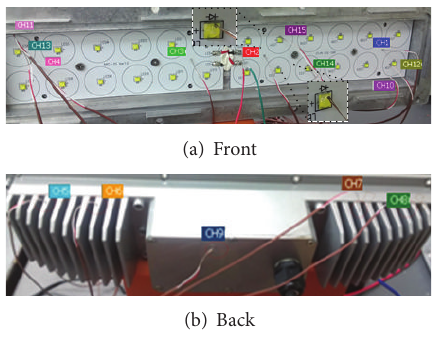
Figure 3: Measuring